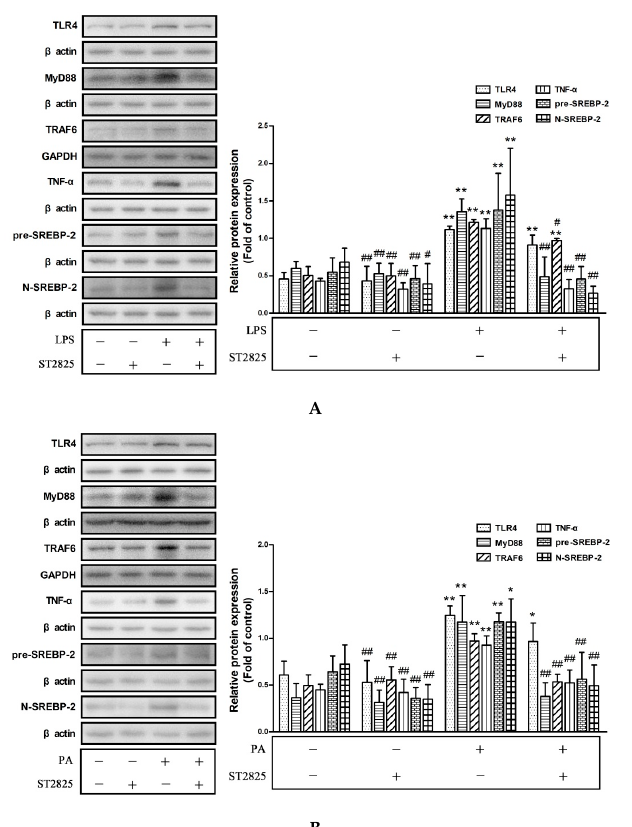
Figure 6. MyD88 inhibitor ST2825 suppressed inflammation and SREBP-2 expression in LPS- or PA-treated HepG2 cells. HepG2 cells were pre-treated with 20 μ mol/L ST2825 for 2 h and then treated with LPS (1 μ g/mL) for 12 h ( A ) or with PA (200 μ mol/L) for 24 h ( B ). The protein levels of TLR4, MyD88, TRAF6, TNF- α , SREBP-2 precursor (pre-SREBP-2), and SREBP-2 mature forms (N-SREBP-2) were measured by Western blotting. The results are presented as means ± SD of three independent experiments; *: p < 0.05 vs. control; **: p < 0.01 vs. control; #: p < 0.05 vs. LPS or PA alone; ##: p < 0.01 vs. LPS or PA alone.